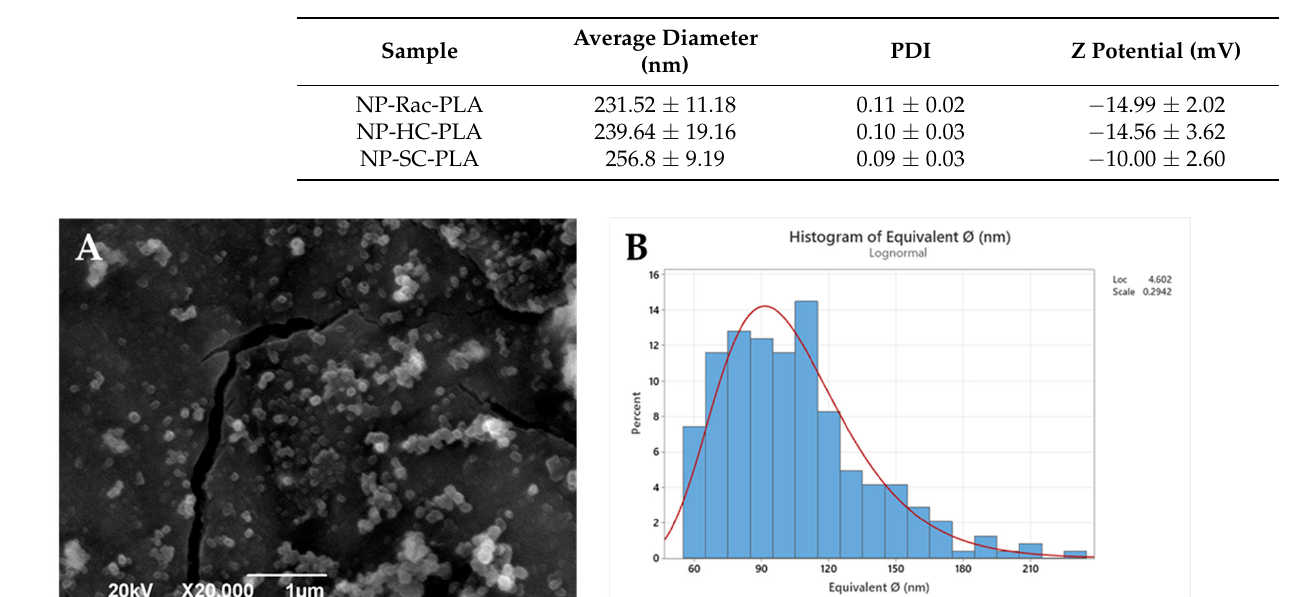
Figure 3. SEM image ( A ) and histogram ( B ) of the statistical diameter